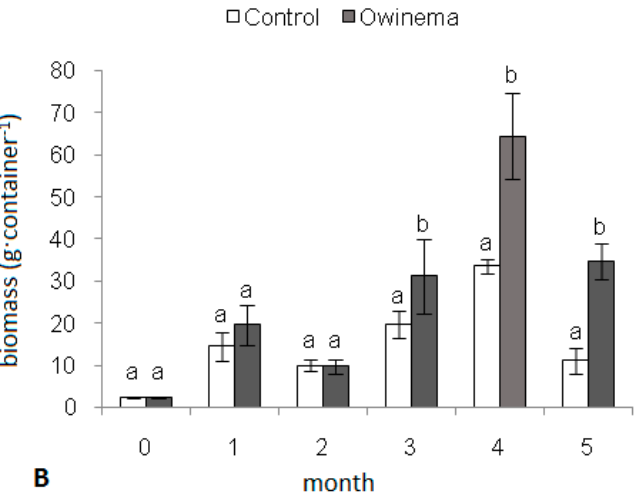
Figure 3. Mean biomass of E. fetida (g ∙ container − 1 ± SD) in experimental ecological boxes depending on the presence of an Owinema bio-preparation (50 mln larvae m − 2 ) during a 5 month experiment: ( A ) mature, ( B ) immature (a, b indicate significant differences between two means).